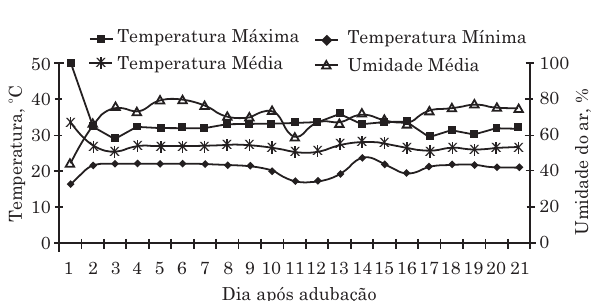
Figura 2. Temperatura e umidade relativa no interior da casa de vegetação referentes ao período de avaliação das perdas por volatilização da